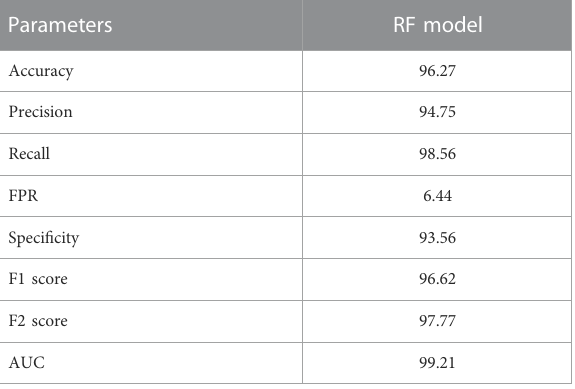
TABLE 5 Different performance parameters of the random forest model ( fi gures in percentage).